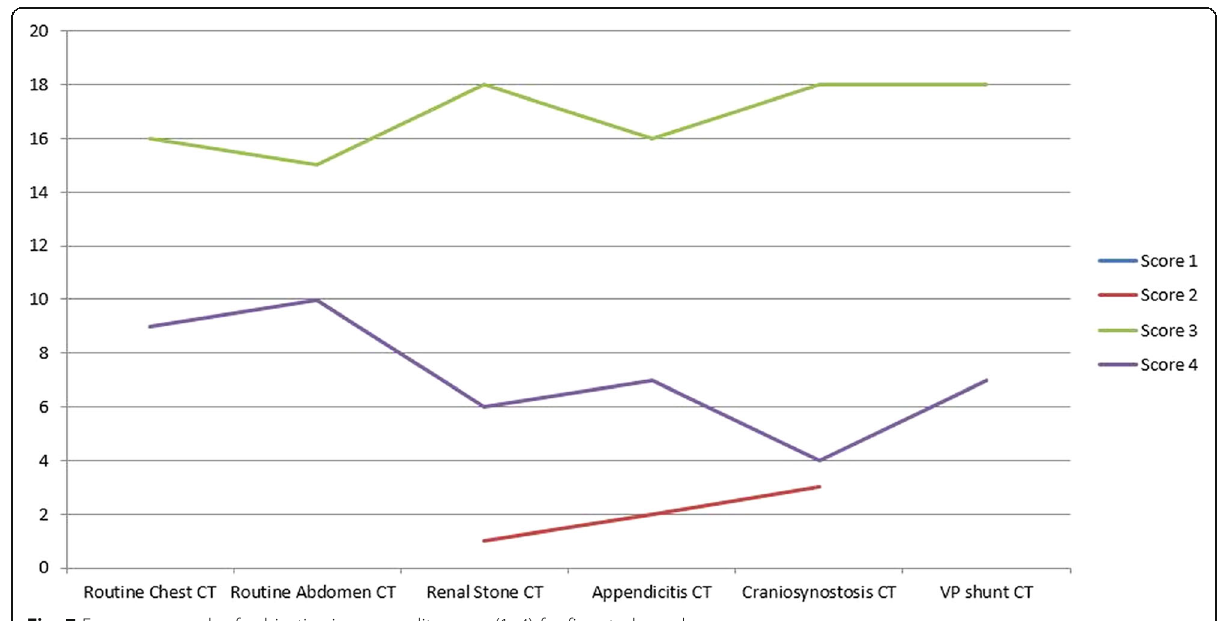
Fig. 7 Frequency graph of subjective image quality score (1 – 4) for five study